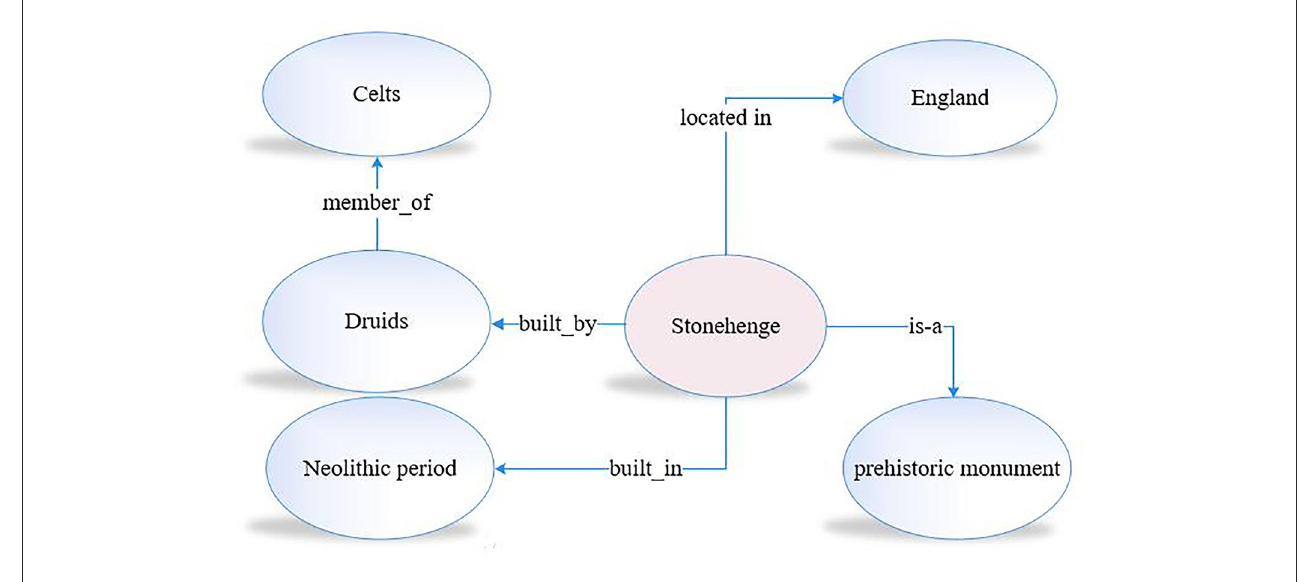
FIGURE2 Knowledge graph fragment.